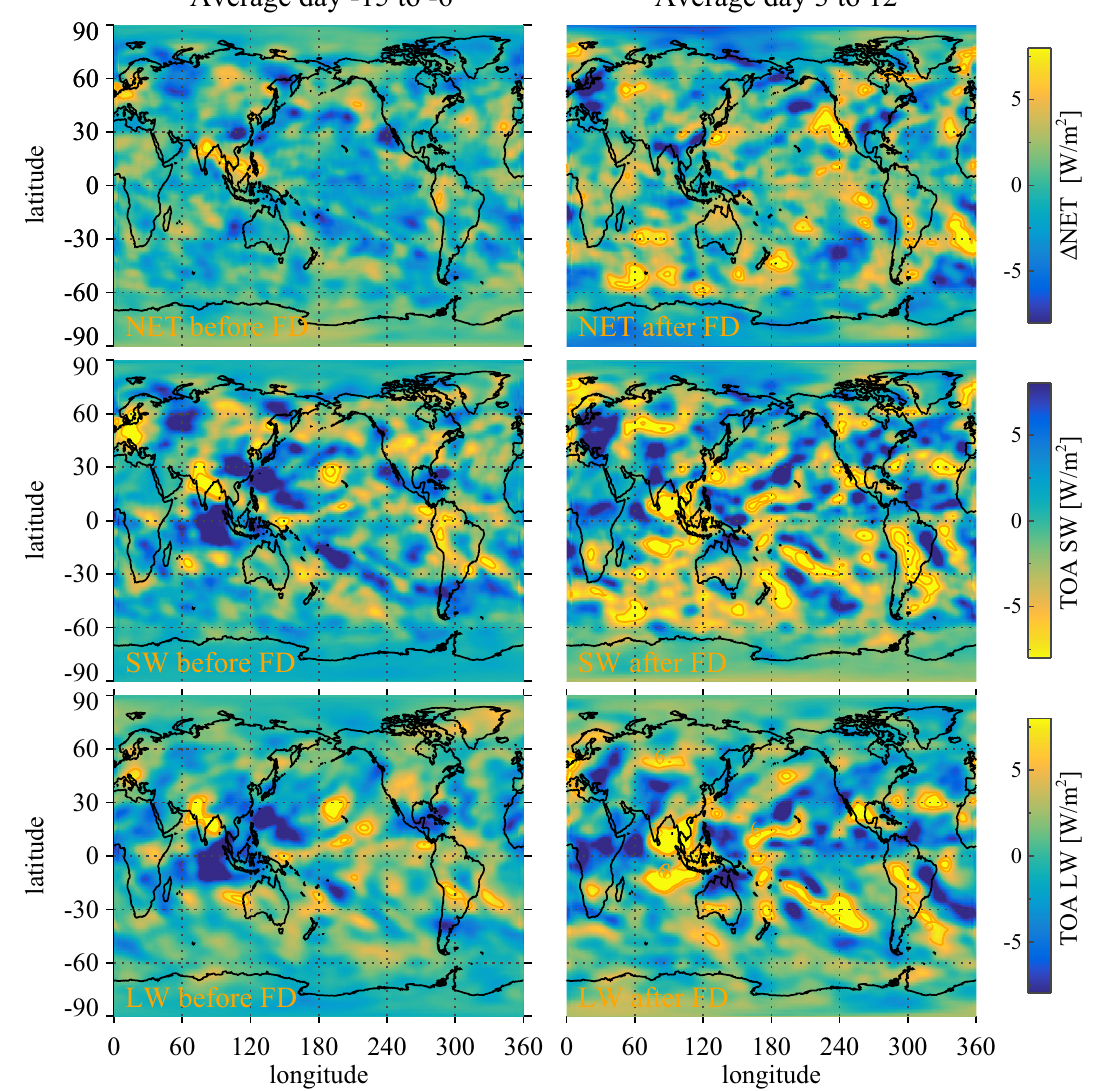
Figure 5. Same figure as Fig. 4 but without the strong FD2 event. Note that the overall patterns are similar to Fig. 4 but as expected a little